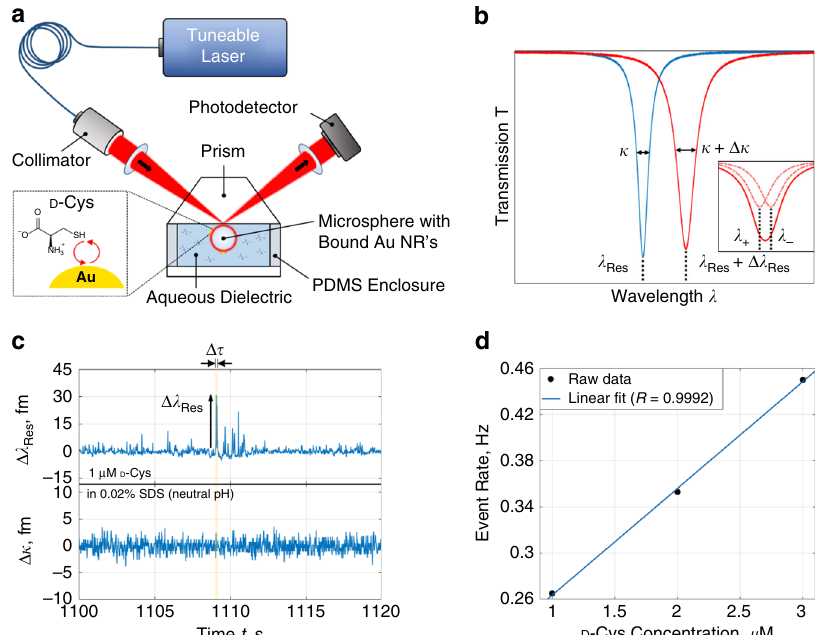
Fig. 1 Optoplasmonic sensor setup and quanti fi cation of adsorbing D -cysteine. a Scheme for LSP-WGM based sensing. A beam emitted from a tuneable laser source, with central wavelength of 642 nm, is focused onto a prism face to evanescently couple to a microspherical WGM cavity. The WGM excites the LSPs of Au NRs on the cavity surface and the hybrid system ’ s transmission spectrum is acquired at the output arm of the setup. D -cysteine ( D -Cys) analytes have carboxyl, thiol, and amine groups. b Sensing through tracking perturbations of the Lorentzian resonance extremum in the transmission = κ are shown in the sub fi gure, as is unresolved mode spectrum. The resonant wavelength λ and linewidth κ that de fi ne the quality factor Q ¼ λ Res Res splitting due to scattering. c Single-molecule time-domain signatures with signal value Δ λ and duration Δ τ from the transit of D -Cys near Au NRs. The Res solvent used is 0.02% sodium dodecyl sulfate (SDS) in deionised water. d Linear dependence of event frequency on analyte concentration that suggests fi rst-order rates. Events conform to a Poisson process (Supplementary Fig.